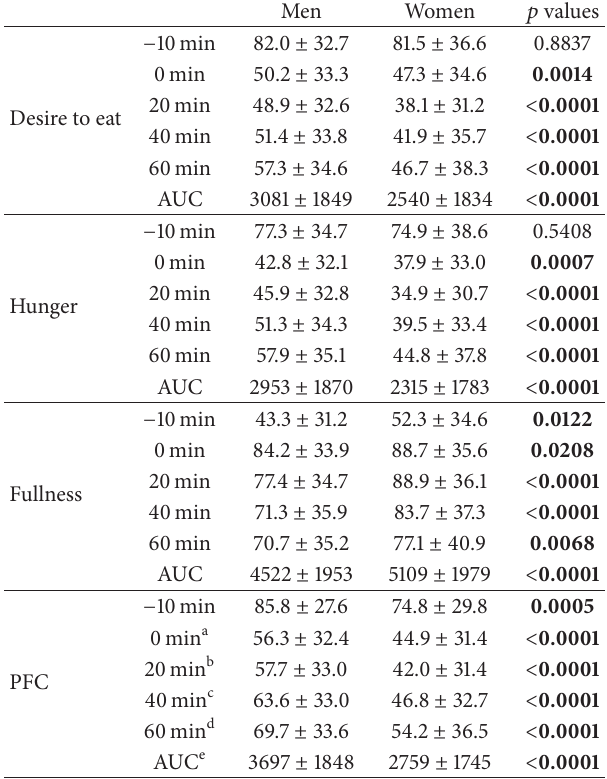
Table 4: VAS values (mm) at each time point and their related and AUC (mm × 60 min) in men and